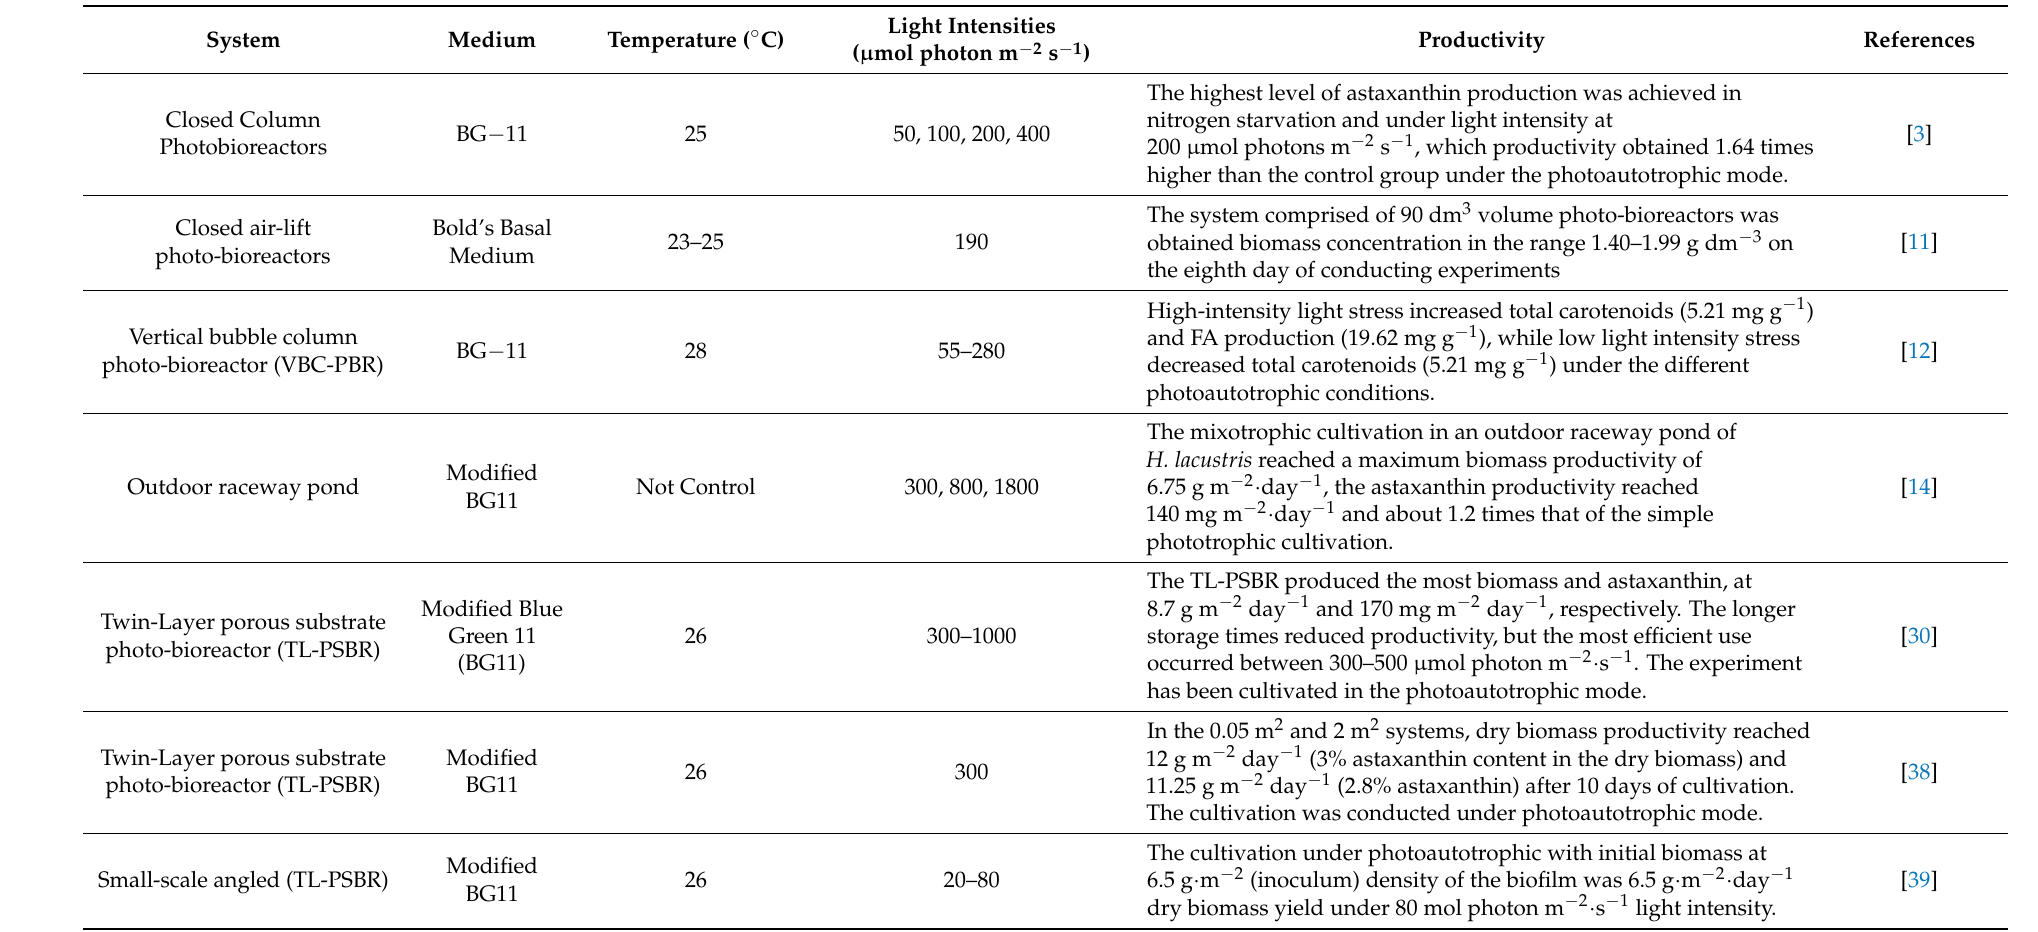
Table 1. Summarized recent research of type cultivation H. lacustris for astaxanthin production in open and close system